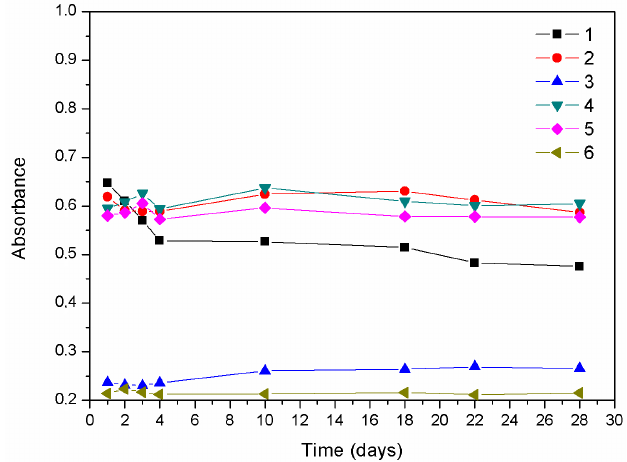
FIGURE 3 - Stability of 10 mg L -1 folic acid solutions in the presence of light, using 0.27 mol L -1 Na 283.0 nm (2), 365.5 nm (3)) and 0.1 mol L -1 NaOH (255.5 nm (4), 283.0 nm (5), 365.5 nm